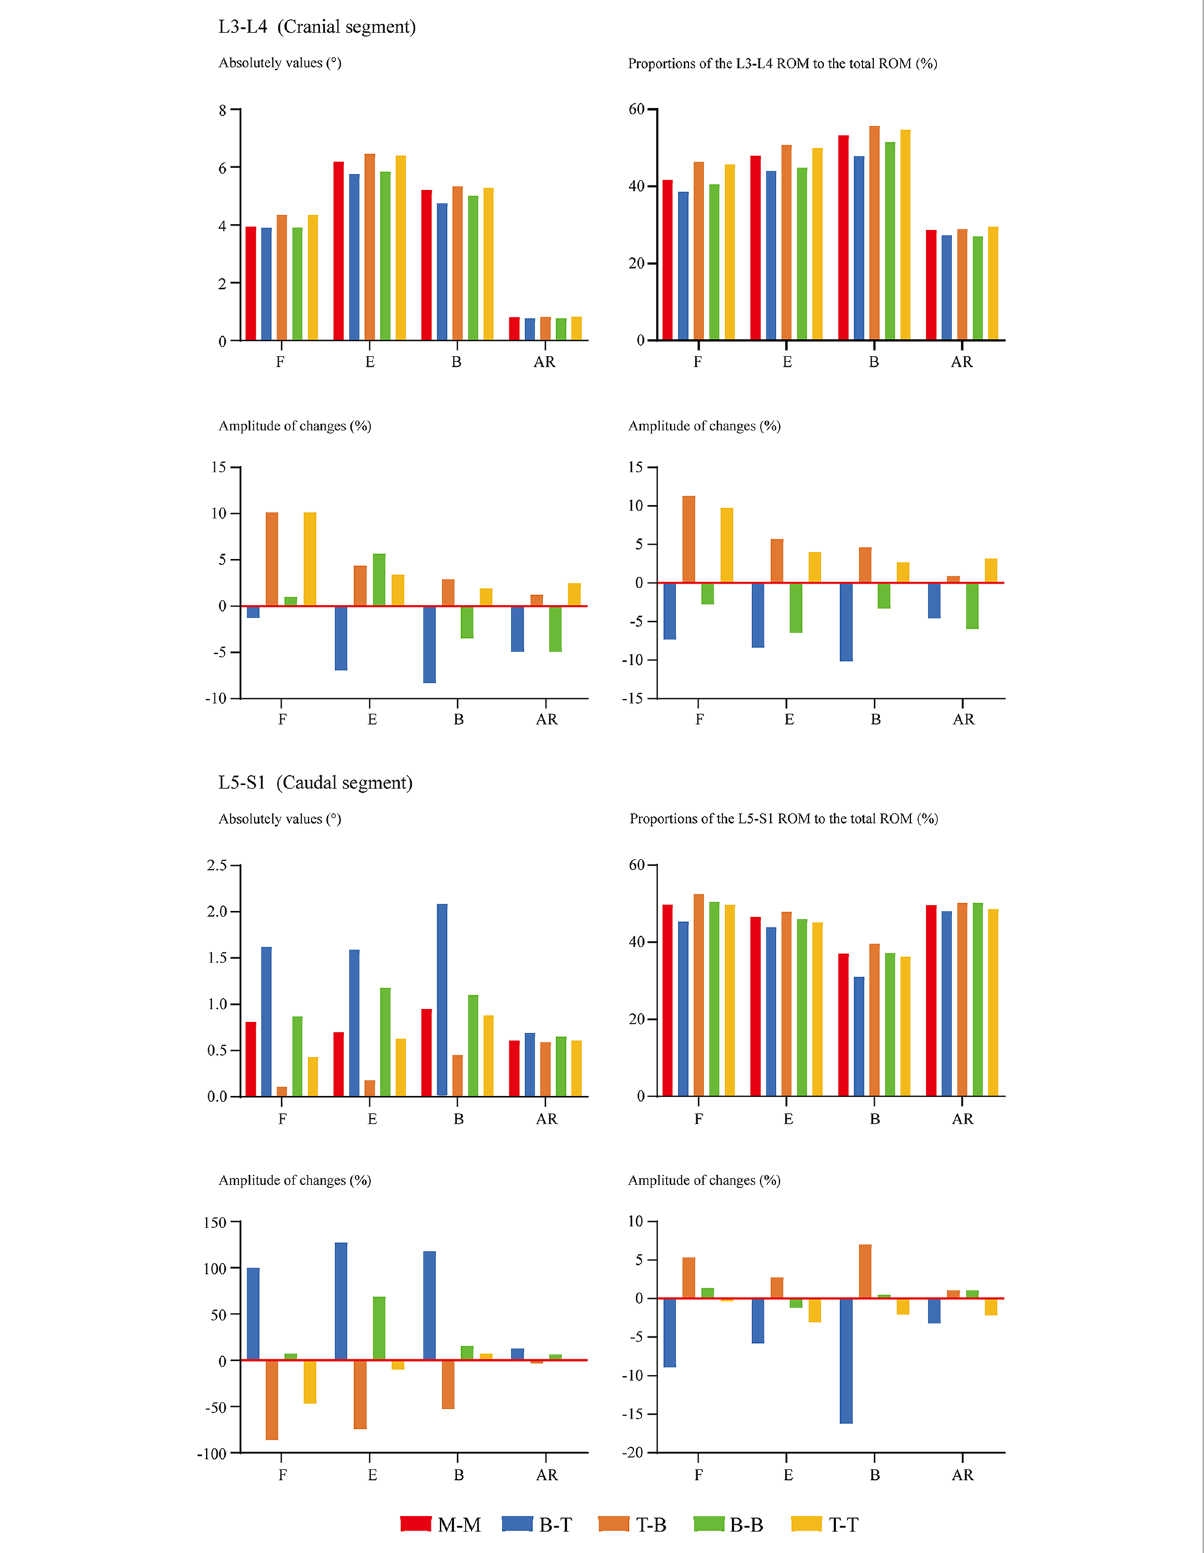
FIGURE 3 Comparison of cranial and caudal adjacent segments ’ ROM between surgical models with different insertional screw positions. F, Flexion; E, Extension; B, Bending; AR, Axial